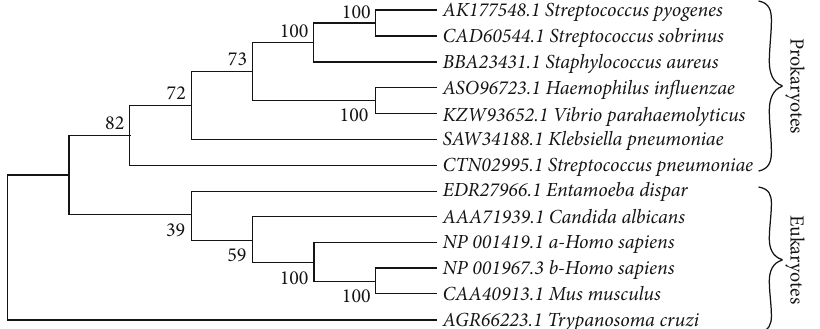
Figure 3: Evolutionary relationships of NTHiENO. The evolutionary history was inferred using the neighbor-joining method [56]. The bootstrap consensus tree inferred from 1000 replicates [57] is taken to represent the evolutionary history of the taxa analyzed [57]. Branches corresponding to partitions reproduced in less than 50% bootstrap replicates are collapsed. The percentages of replicate trees in which the associated taxa clustered together in the bootstrap test (1000 replicates) are shown next to the branches [57]. The evolutionary distances were computed using the Poisson correction method [58] and are in the units of the number of amino acid substitutions per site. This analysis involved 13 amino acid sequences. All ambiguous positions were removed for each sequence pair (pairwise deletion option). There were a total of 454 positions in the fi nal dataset. Evolutionary analyses were conducted in MEGA X